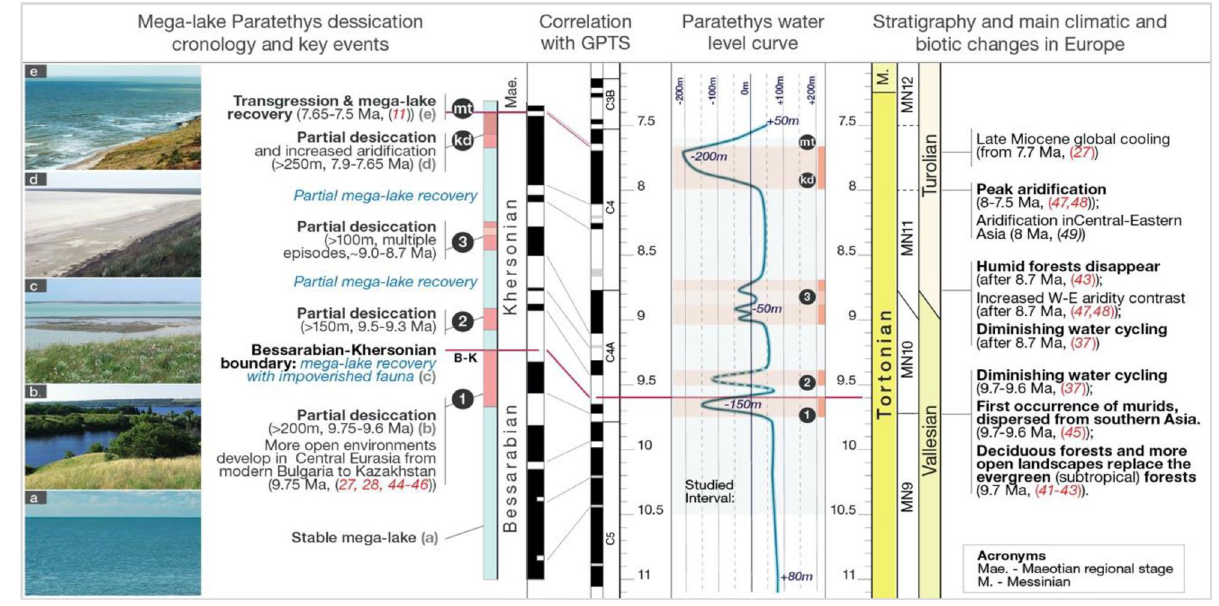
Figure 3. Chronology of the megalake Paratethys hydrological crises, correlations with the Geomagnetic Polarity Time Scale (GPTS 2020 25 ), Paratethys water-level curve compared with present-day sea-level in Black Sea (adapted after Popov et al. 7 ), stratigraphic correlations (Stratigraphic Stages, Mammal MN zones, European Mammals Zones) and bio-climatic events from neighbouring Europe and Asia. Images on the left exemplify the dynamics of the north Paratethys region: ( a ) submerged lake domain; ( b ) lakes and widespread semi-open landscapes; ( c ) submerged lake domain with some semi-open landscapes; ( d ) dry-arid plains and lagoons; e. submerged lake domain and semi-open landscapes (Image source: Wikimedia